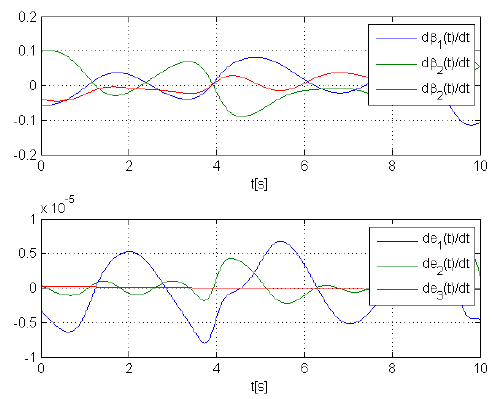
Figure 10. The velocity